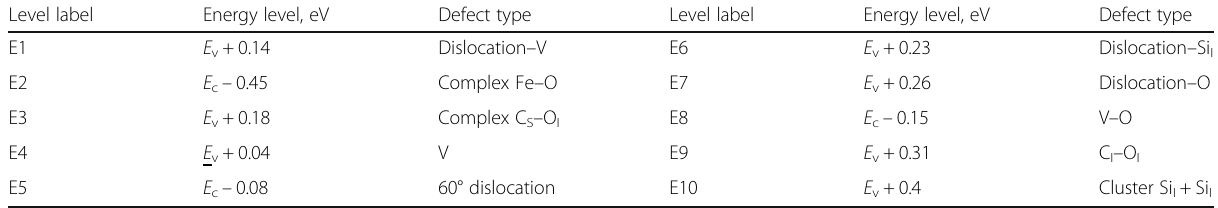
Table 2 Energy of deep levels and type of defect Level